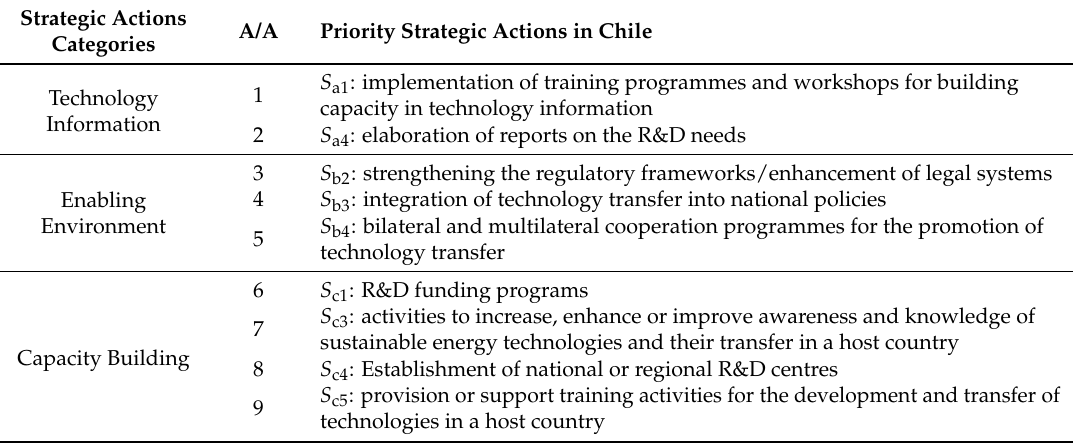
Table 3. Priority strategic actions for the promotion of technology transfer in Chile.